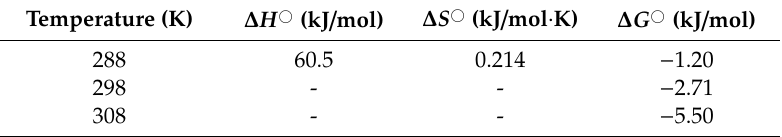
Table 4. Thermodynamic parameters for adsorption of CV on BC-PKS (initial concentration: 400 mg /